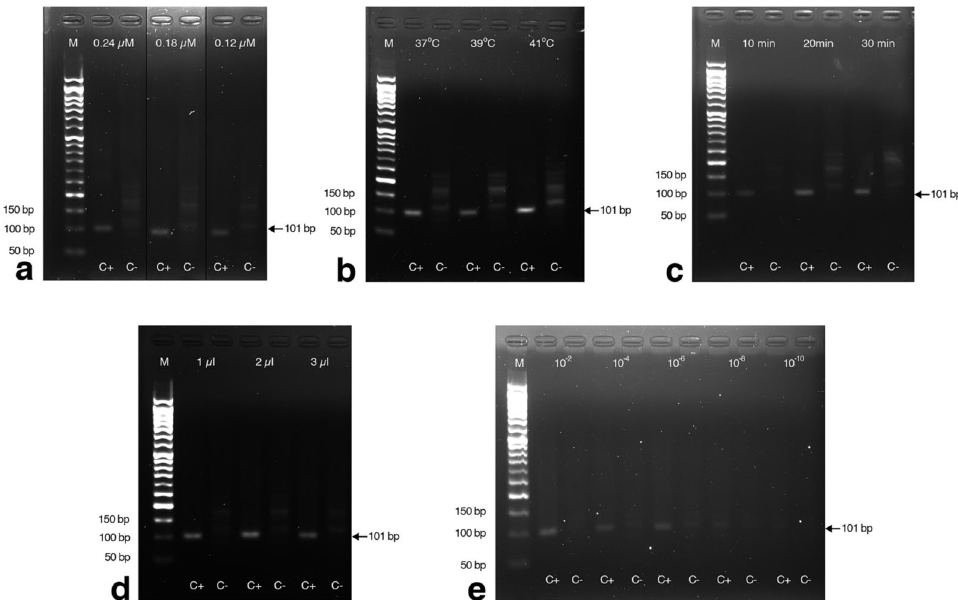
Figure 1. Optimization of FeLV DNA provirus detection by nRPA. Representative gel images showing the results from the nRPA reaction at different ( a ) inner primer concentrations (0.24, 0.18, and 0.12 µM) incubated at 37 °C for 20 min; ( b ) temperatures (37 °C, 39 °C, and 41 °C) incubated for 20 min with 0.36 µM inner primers; ( c ) incubation times (10, 20, and 30 min) at 37 °C with 0.18 µM inner primers; and ( d , e ) dilutions of primary RPA products at 37 °C for 10 min with 0.18 µM inner primers. C+, positive DNA control; C−, no-template control; M, molecular weight marker. Gel in ( a ) was cropped, see Supplementary Fig. S1 for the full-length picture.